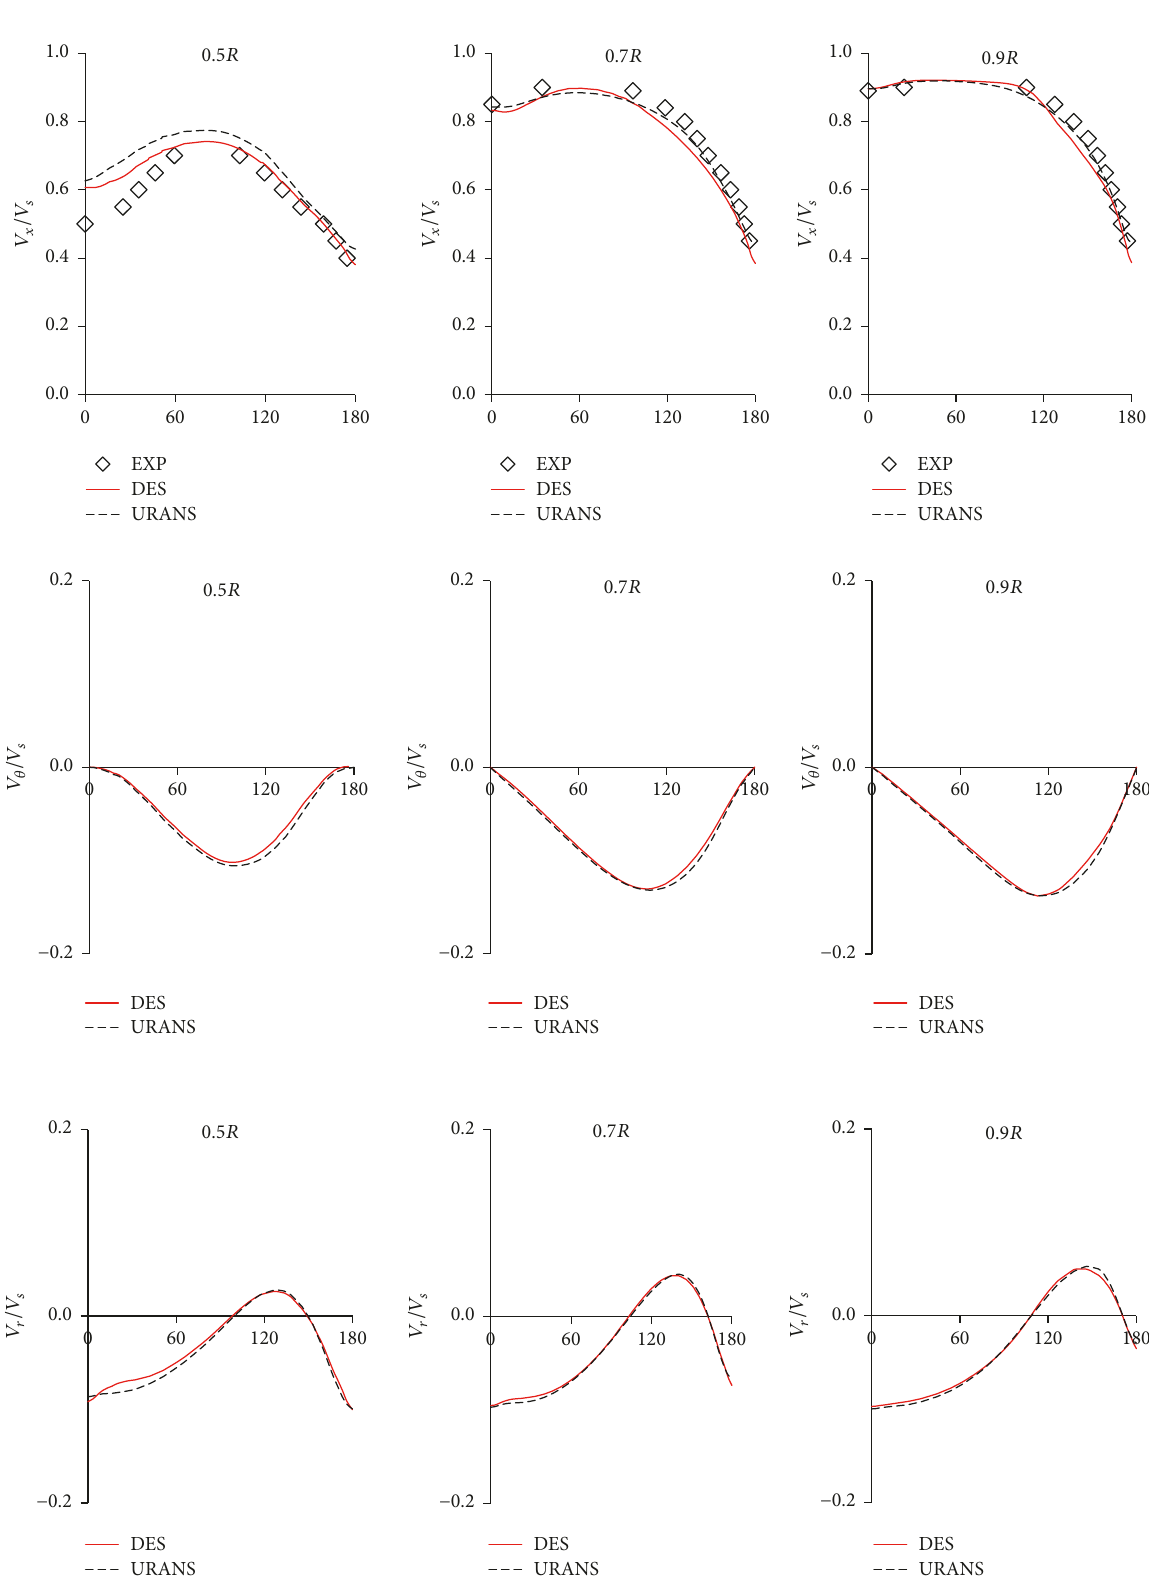
Figure 12: Circumferential distributions of axial, tangential, and radial velocities of 0.5𝑅 , 0.7𝑅 , and 0.9𝑅